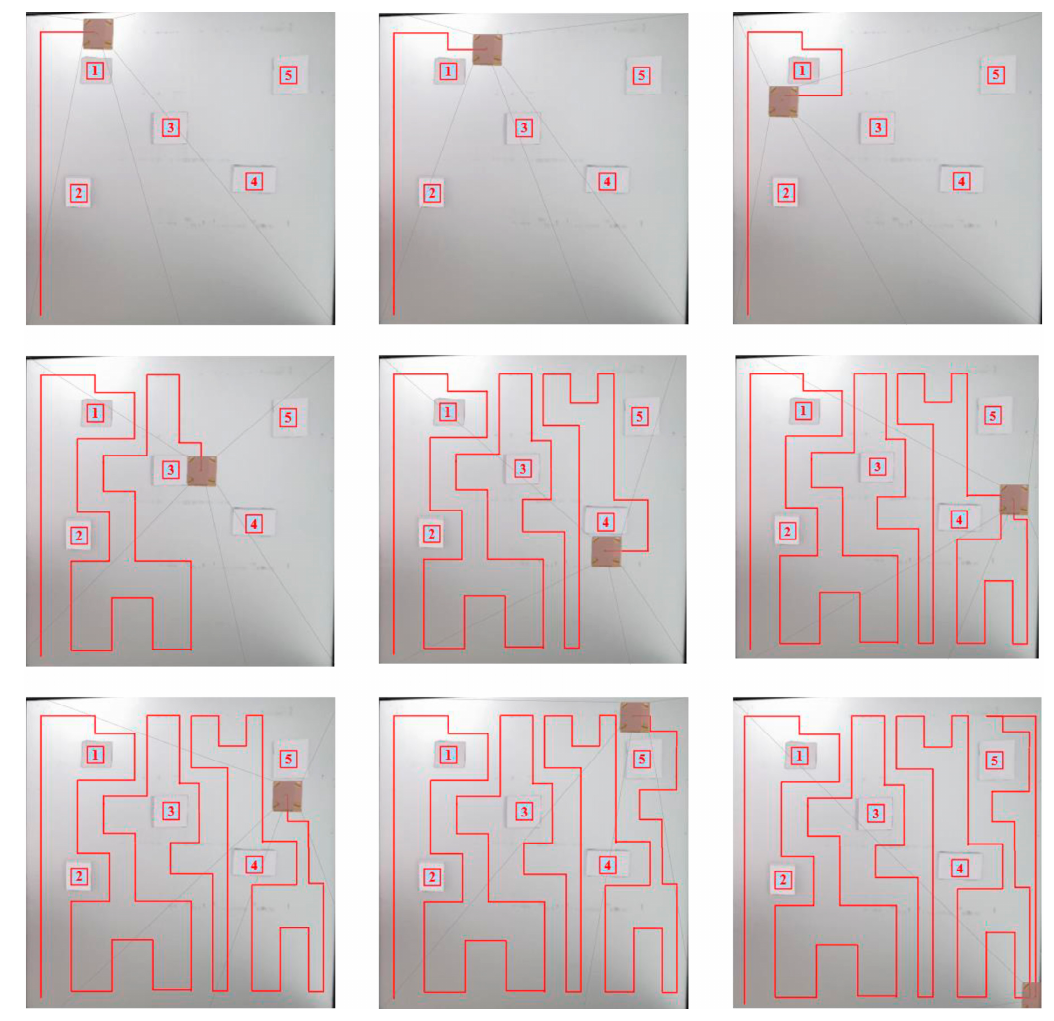
Figure 14. Full-coverage path-planning experiment.